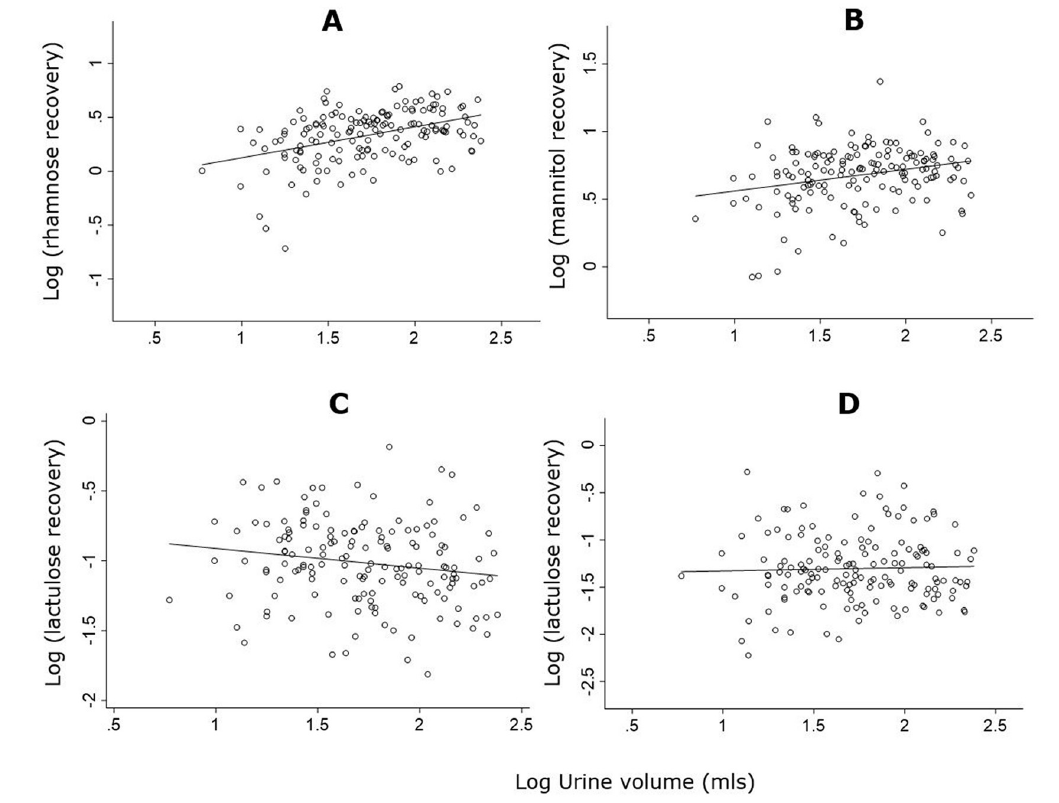
Fig 1. Correlations between sugar recoveries and urine volume. A = rhamnose recovery (r = 0.41 [p < 0.001]); B = mannitol recovery (r = 0.26 [p < 0.001]); C = lactulose recovery (r = -0.16 [p = 0.004]); D = sucrose recovery (r = 0.035 [p = 0.67]).